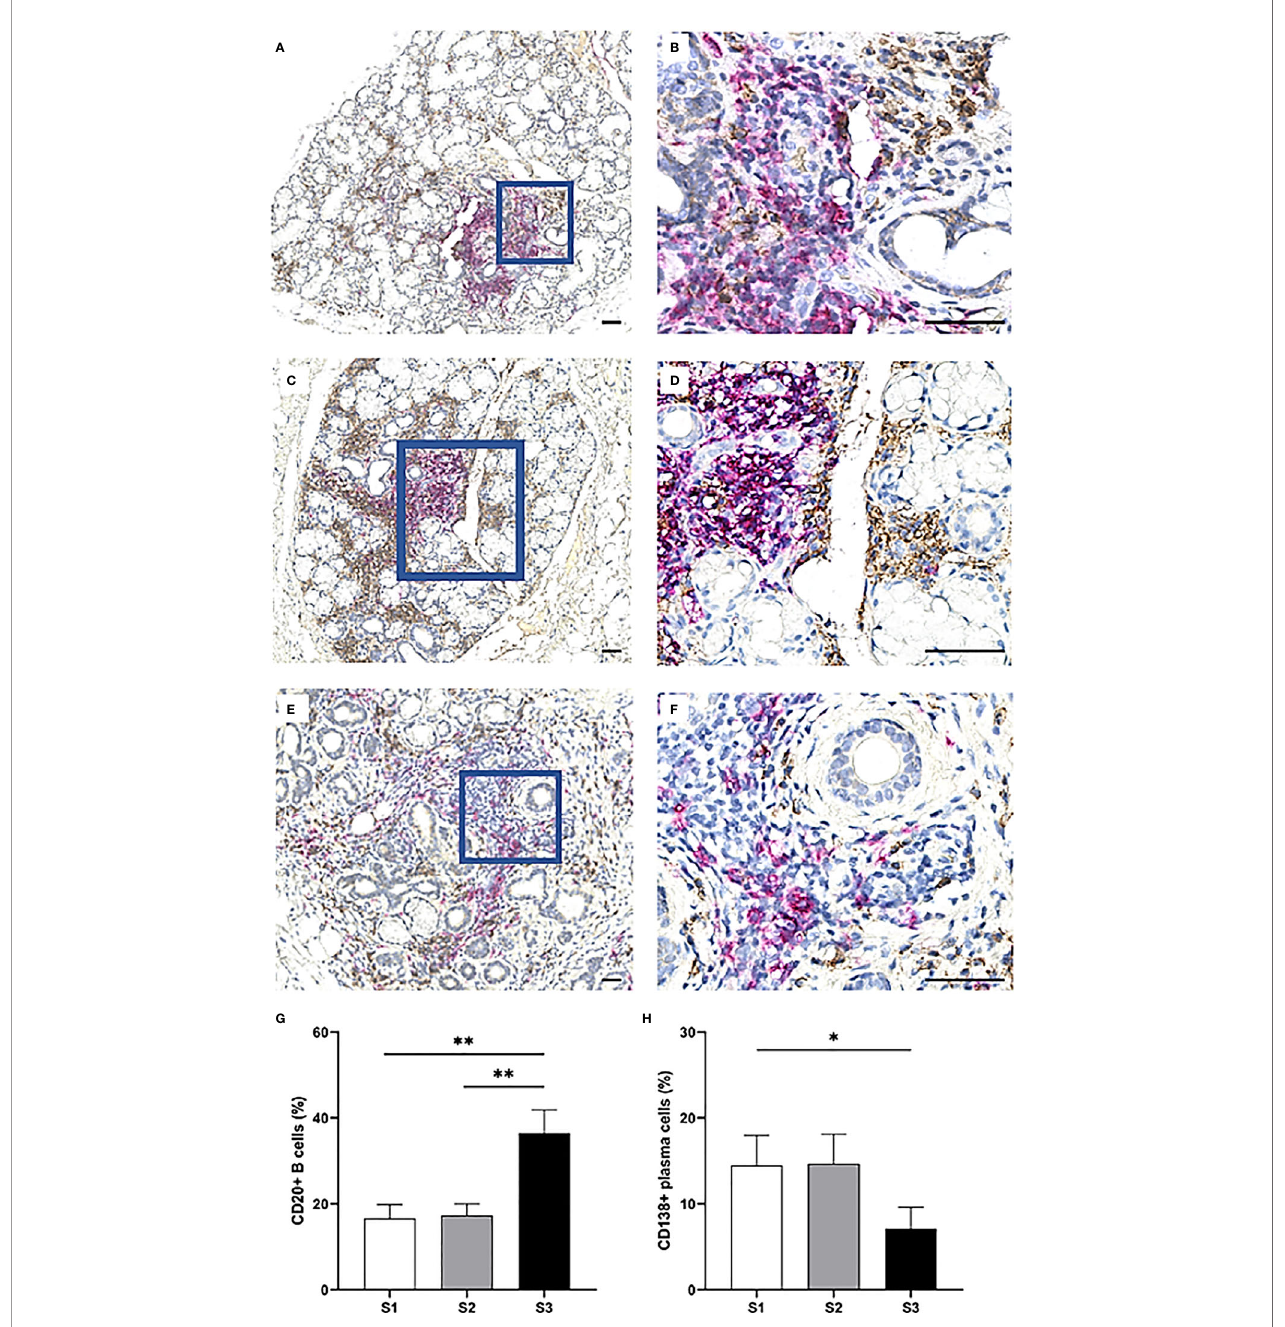
FIGURE 8 | Distribution of CD20 + B cells and CD138 + plasma cells in the MSG of pSS patients. CD20 + B cells (magenta) were mostly observed in large numbers within large focal in fi ltrates and GC, in contrast to CD138 + plasma cells (brown) which were localized throughout the glandular tissue. However, the double staining revealed that both cell-types were commonly found adjacent to adipocytes (A – F) , unlike the other mononuclear cells in this study. CD20 + B cells signi fi cantly increased from S1 to S3 ( p = 0.004) as tested by the Student's T test, from S2 to S3 ( p = 0.004) as tested by the Mann – Whitney U test and were elevated in S3 compared to S1 and S2 combined ( p < 0.001) as tested by the Student's T test. On the other hand, a higher incidence of CD138 + plasma cells in S1 and S2 lesions together was discovered compared to S3 using the Mann – Whitney U test ( p = 0.028). Immunohistochemical staining displaying the distribution of a speci fi c immune cell in three representative examples of focal in fi ltrates in the MSG as classi fi ed into the respective in fl ammatory severity stages; S1 (A, B) , S2 (C, D) , and S3 (E, F) . Image (B) is a magni fi cation of (A) , image (D) is a magni fi cation of (C) , image (F) is a magni fi cation of (E) . Scale bar = 0.5 mm. Bars (G, H) indicate the mean percentage of cell-type number/total in fi ltrating mononuclear cells in each stage and error bars represent ± SEM. Statistical signi fi cance is notated: * = p < 0.05, ** = p ≤ 0.01. The Student's T test and Mann – Whitney U test were